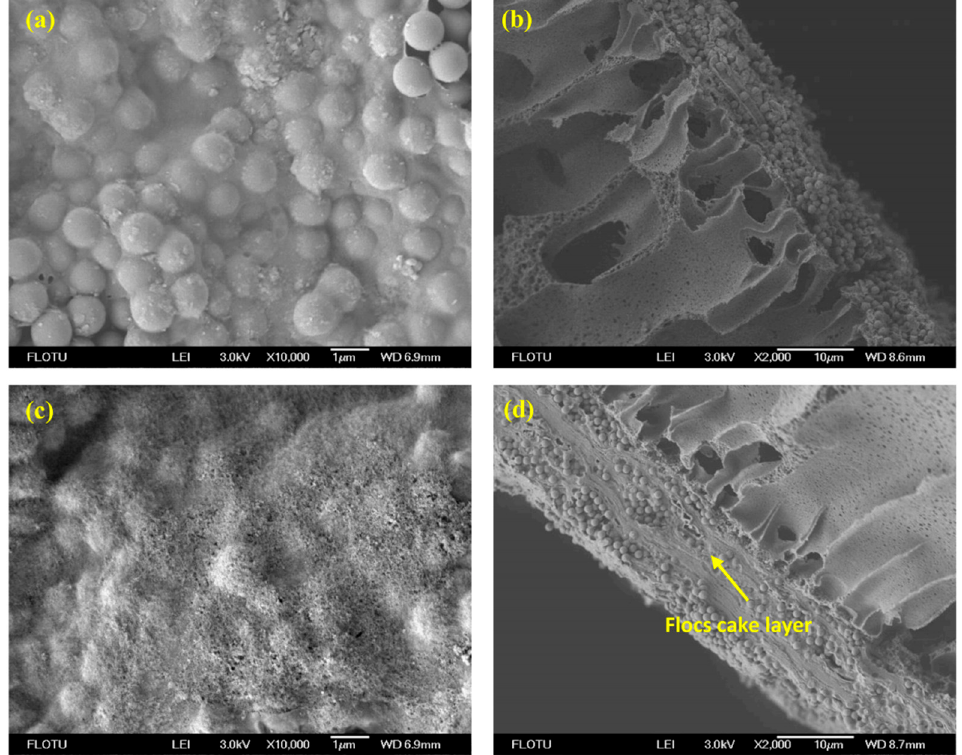
Figure 4. Morphology of the membrane on the 10th day when operated in the presence of 1 μ m PS of 1 mg/L: ( a ) without flocs, surface, ( b ) without flocs, cross-section, ( c ) with 13 mM flocs, surface, and ( d ) with 13 mM flocs, cross-section [140].